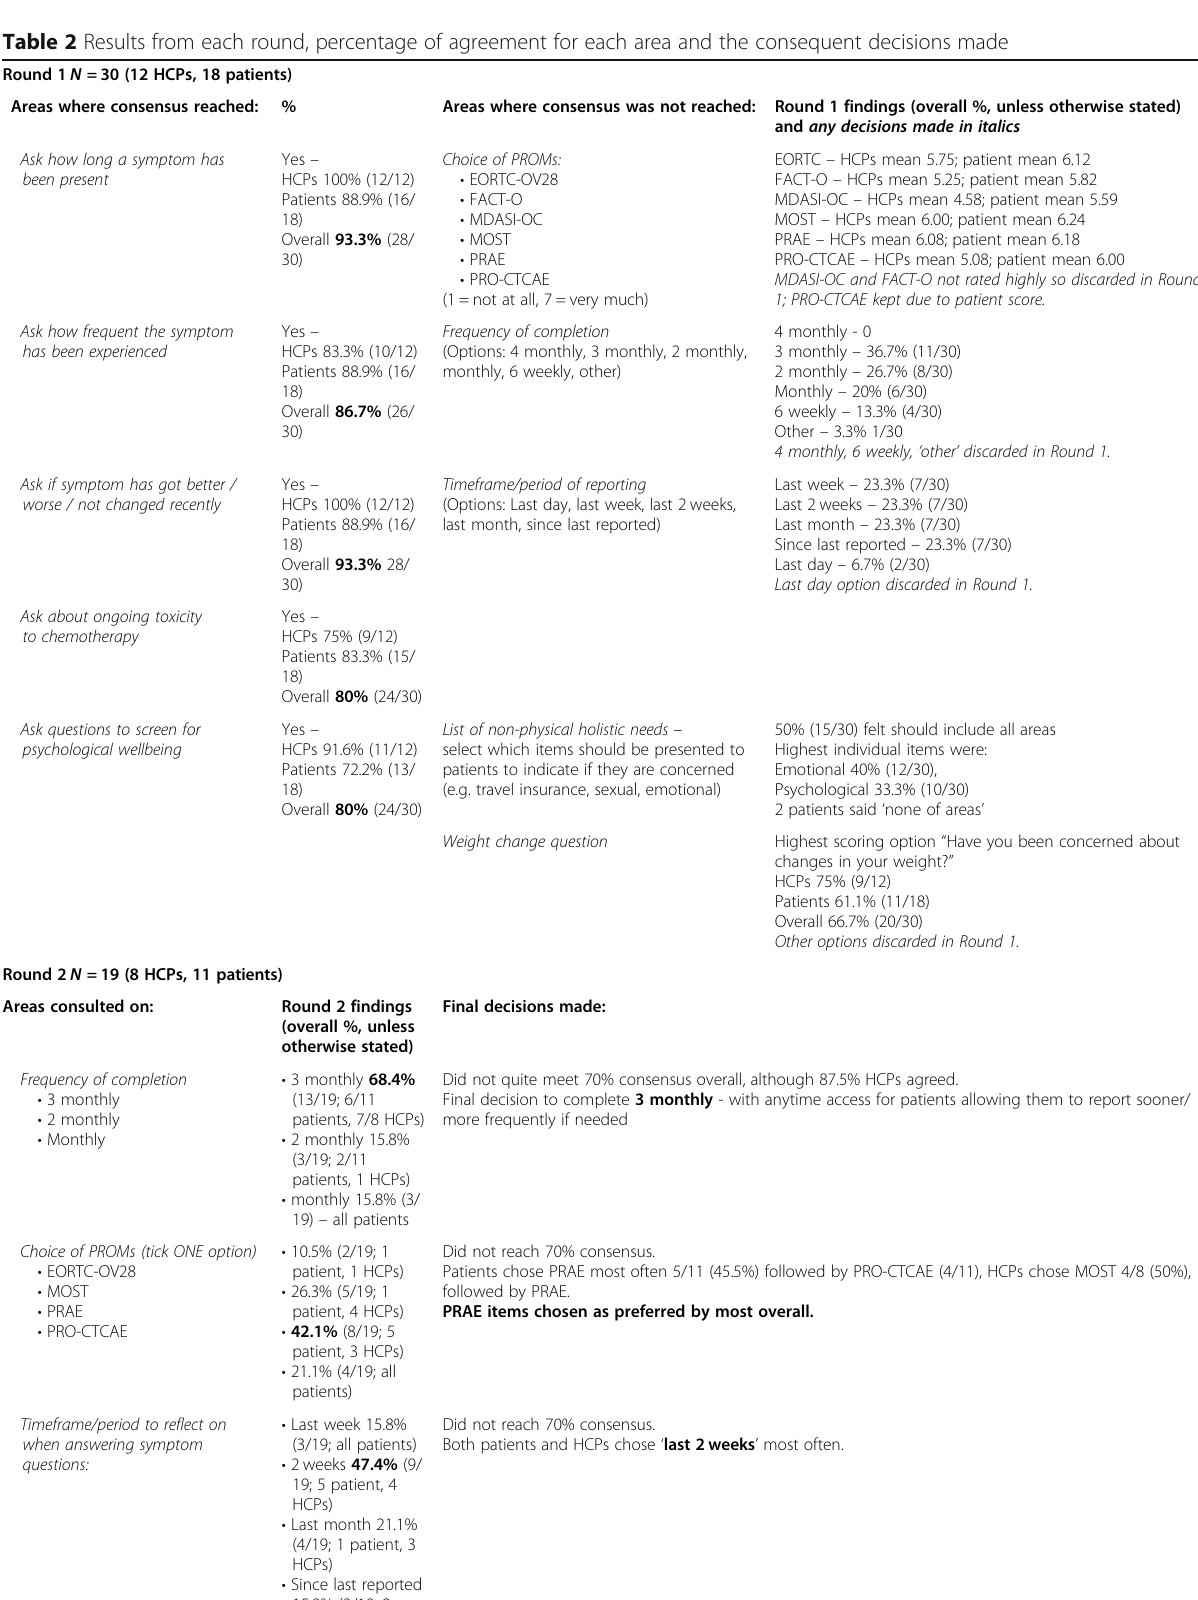
Table 2 Results from each round, percentage of agreement for each area and the consequent decisions made Round 1 N =30 (12 HCPs, 18 patients) Areas where consensus reached: